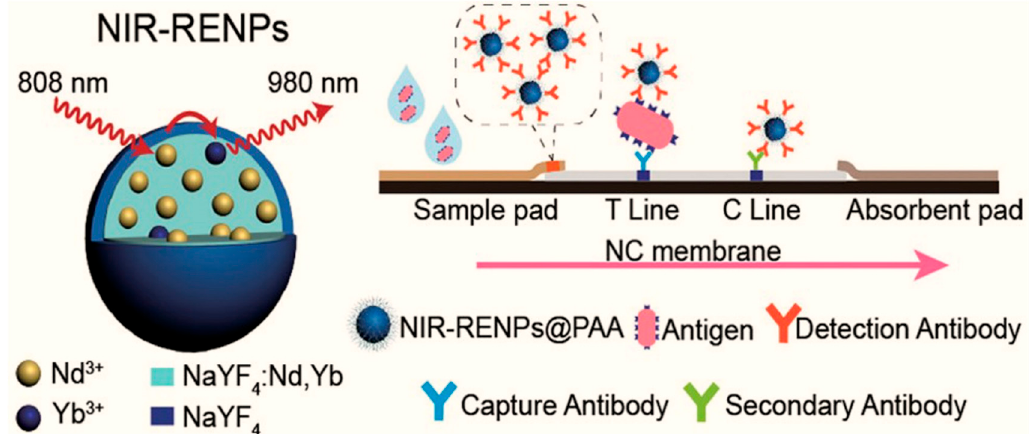
Figure 4. Near-Infrared Lanthanide—Doped Nanoparticles (NIR-RENPs), lateral flow immunoassay test format for the viral antigen detection. Reproduced with permission [124]. Copyright © 2020 American Chemical Society .